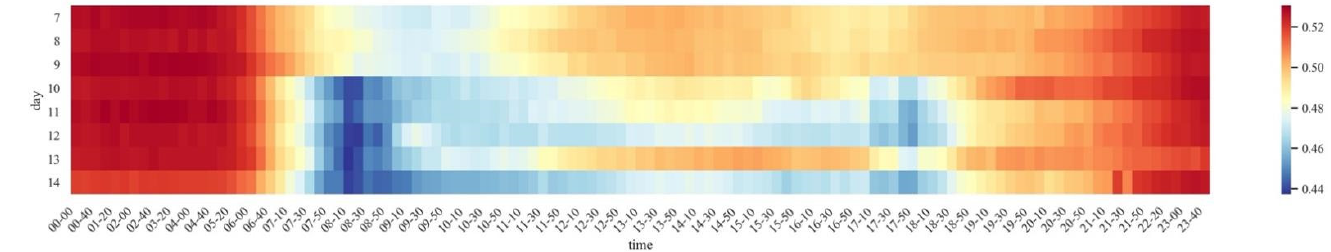
Figure 3. Change in NAB of Hangzhou public bicycle system on typical days.